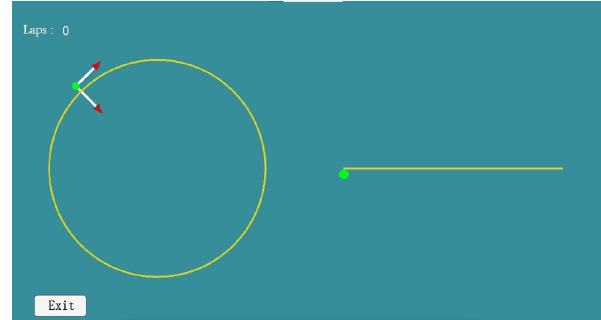
Figure 6. Graphical guidance